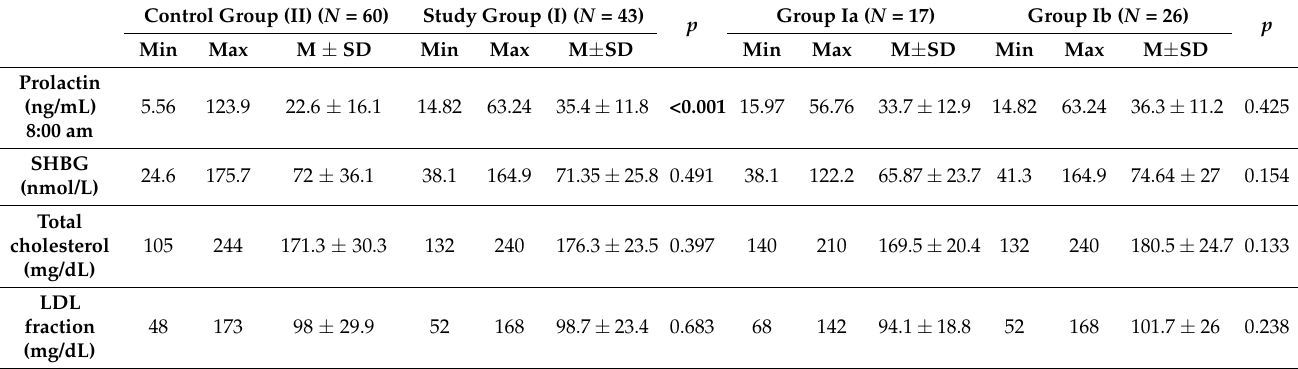
Table 3. The concentrations of the prolactin, SHBG, total cholesterol, and LDL fraction in individual groups. Control Group (II) ( N = 60) Study Group (I) ( N =